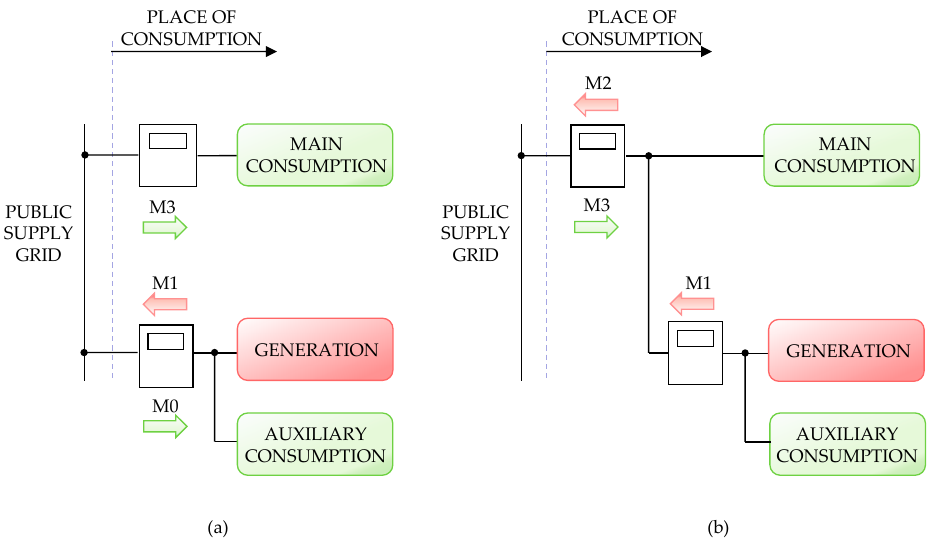
Figure 1. Connection types for net settled facilities under the Danish regulatory framework: ( a ) Direct-connected; ( b ) Installation-connected. Source: self-elaboration.